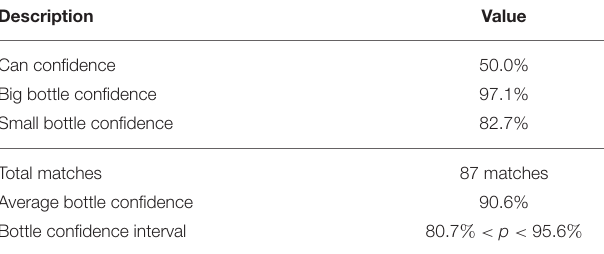
TABLE 1 | Summary of results for object